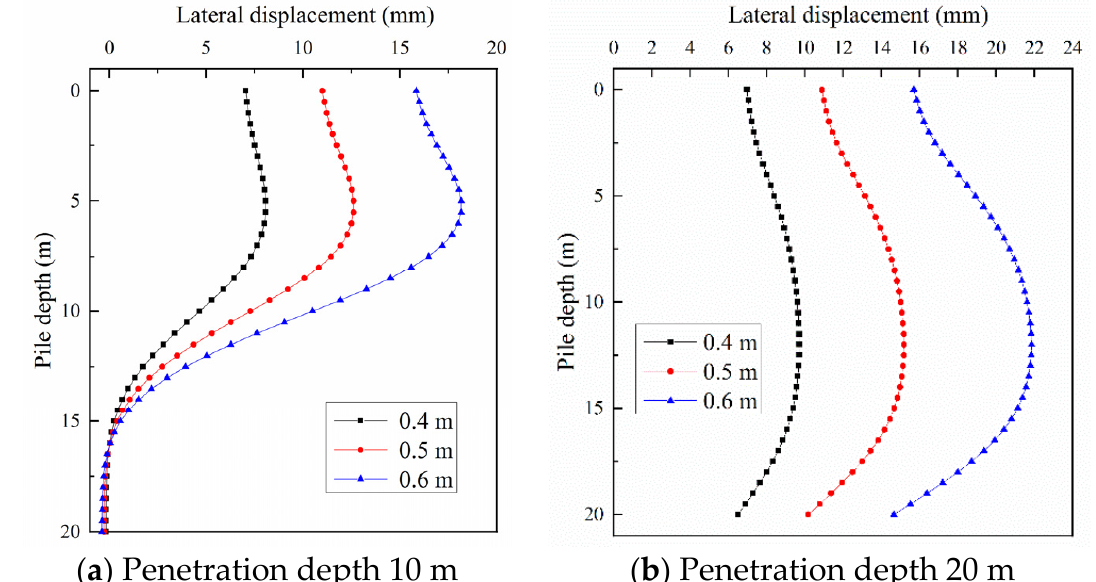
Figure 16. Influence of the diameter of the new pile on the lateral displacement of the used pile.